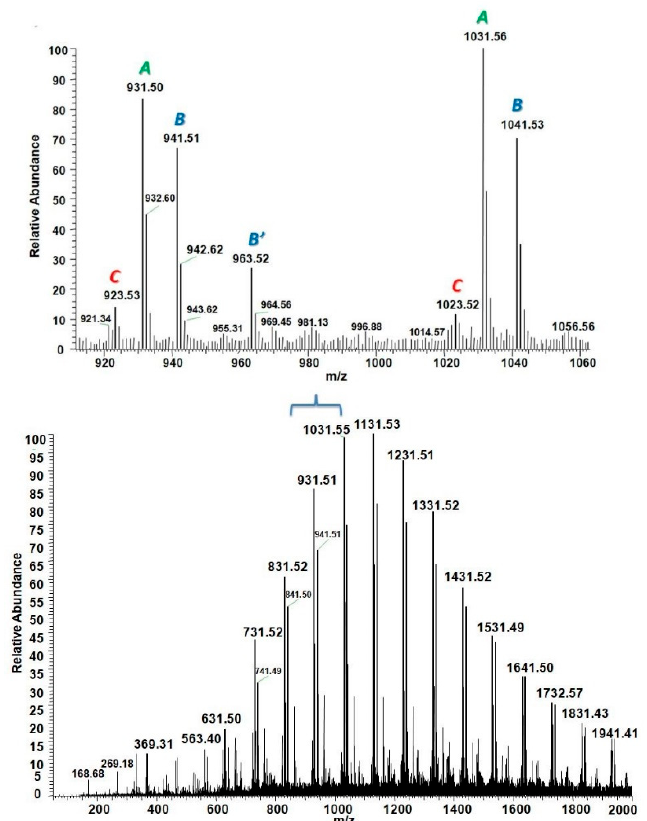
Figure 2. ESI ‐ MS spectrum (positive ‐ ion mode) of PVL oligomers and the spectral expansion in the range m/z 910–1050 (Sample 1, Table 1).